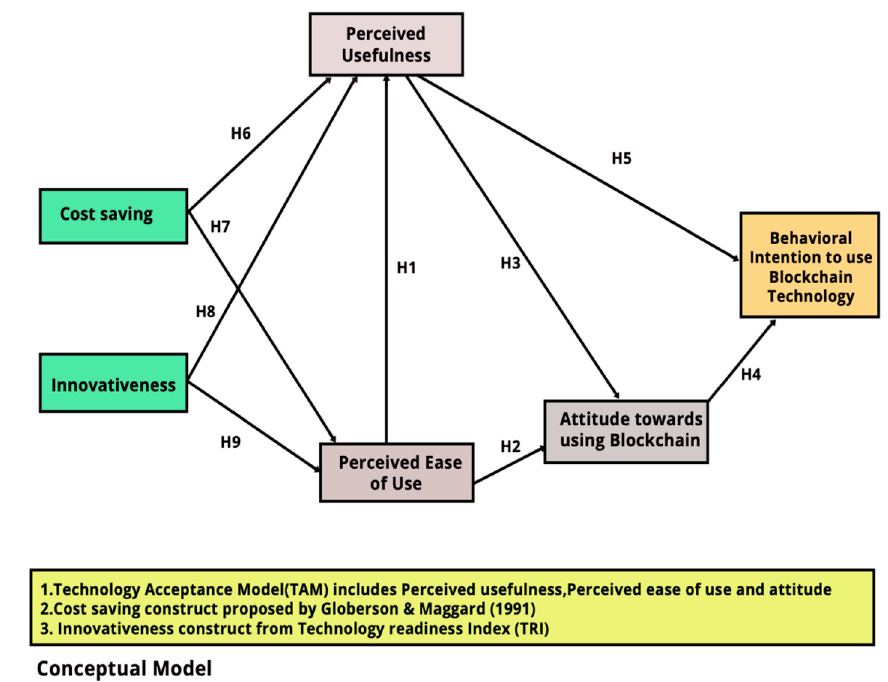
Figure 2. Conceptual model.